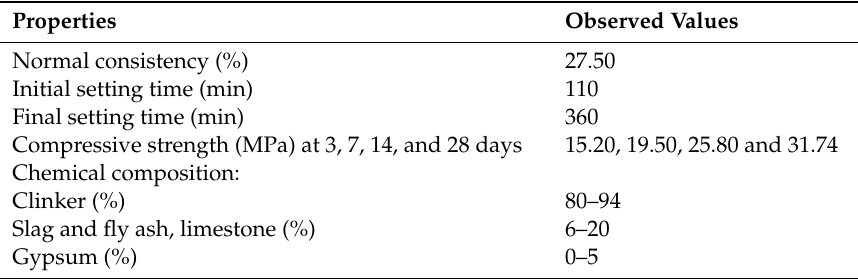
Table 2. Physical and main constituents of cement.